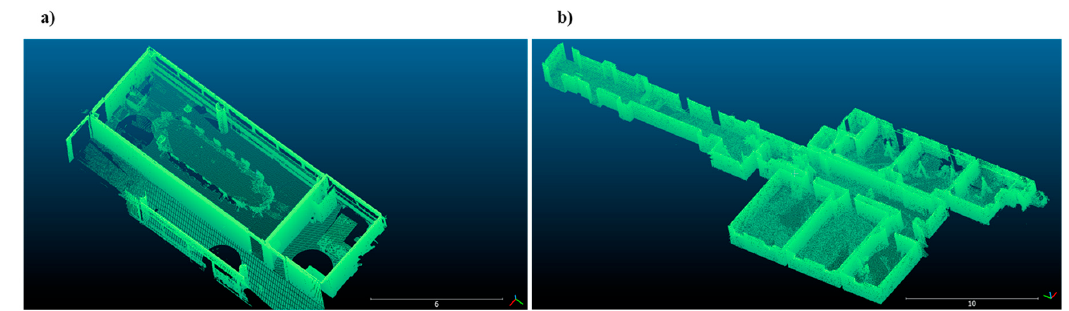
Figure 7. Three-dimensional view of the point clouds used as ( a ) case study 3 (scale bar of 6.0 m), and ( b ) case study 4 (scale bar of 10.0 m). The ceiling is removed in all views to facilitate visualization.